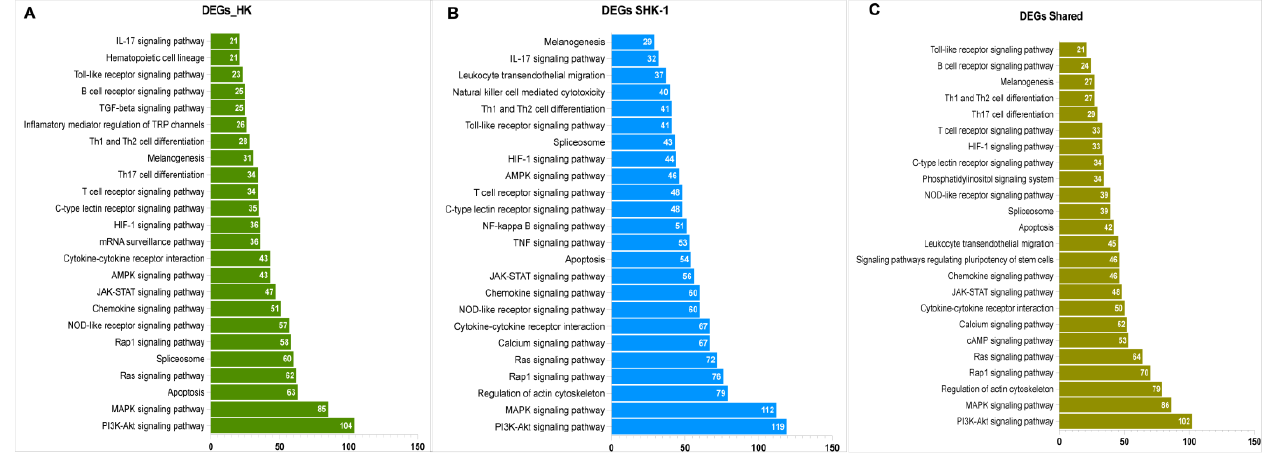
Figure 3. KEGGs enrichment analysis for exclusive and common DEGs mRNA of SHK-1 cell line and salmon HK exposed to recombinant Cr-cathepsin. ( A ) Top pathways of exclusive DEGs mRNA of salmon HK. ( B ) Top pathways of exclusive DEGs mRNA of exclusive of SHK-1 cell line. ( C ) Top pathways of common DEGs mRNA salmon HK and SHK-1 cell line.